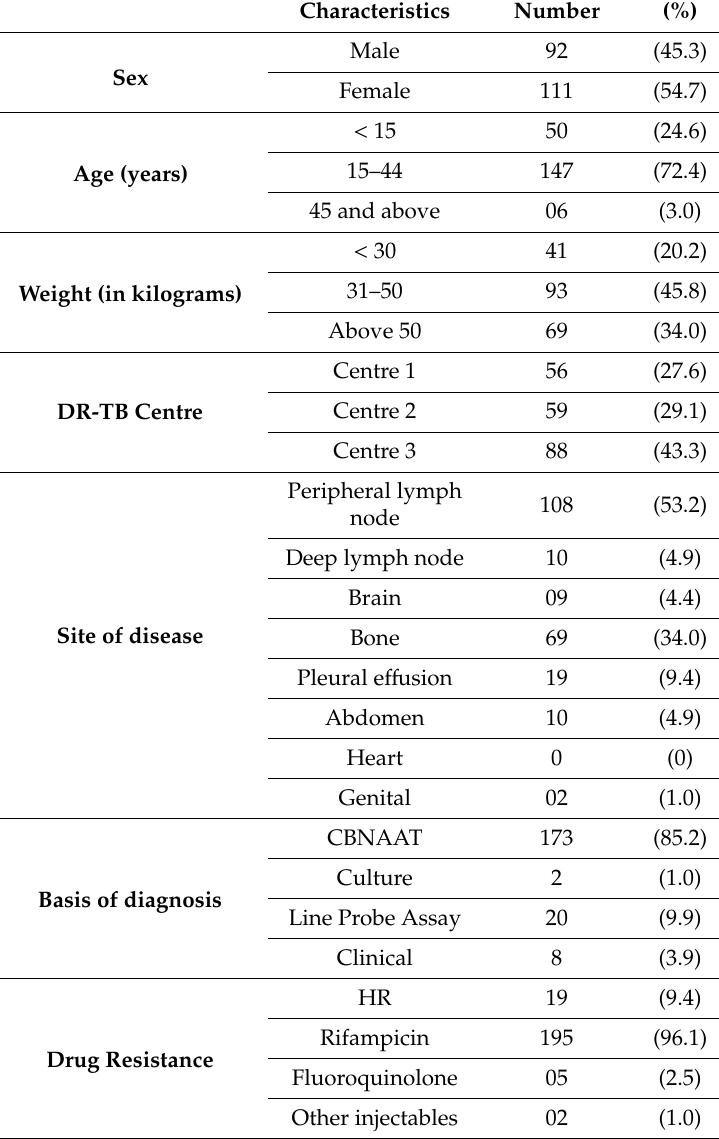
Table 1. Baseline demographic and clinical characteristics of drug-resistant extrapulmonary TB patients in Delhi in 2016 ( n =